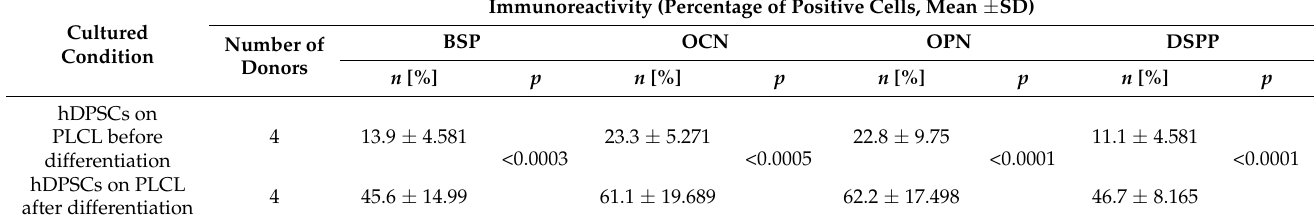
Table 5. Comparison of bone-related proteins expression on hDPSCs growing onto PLCL before and after differentiation towards osteoblasts.